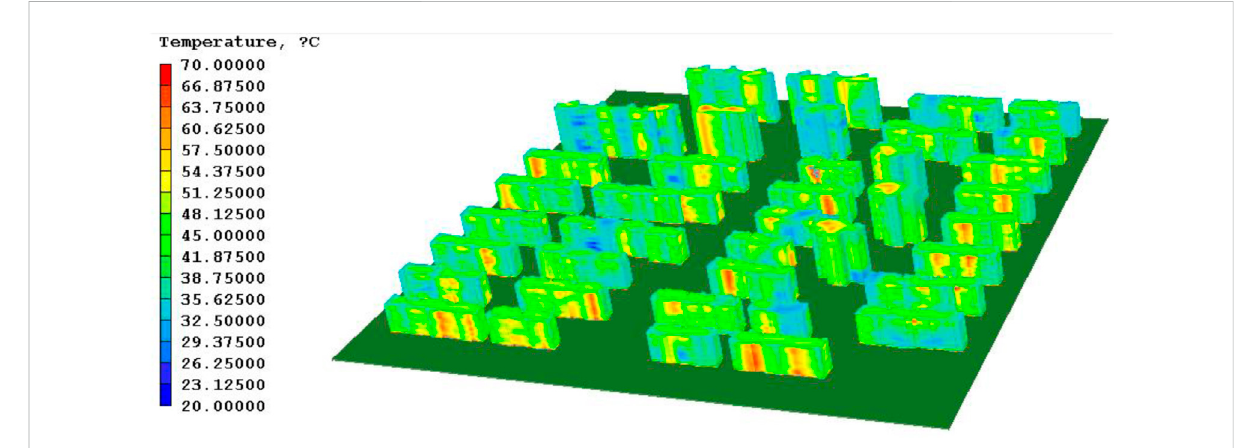
FIGURE 2 Building surface temperature distribution.